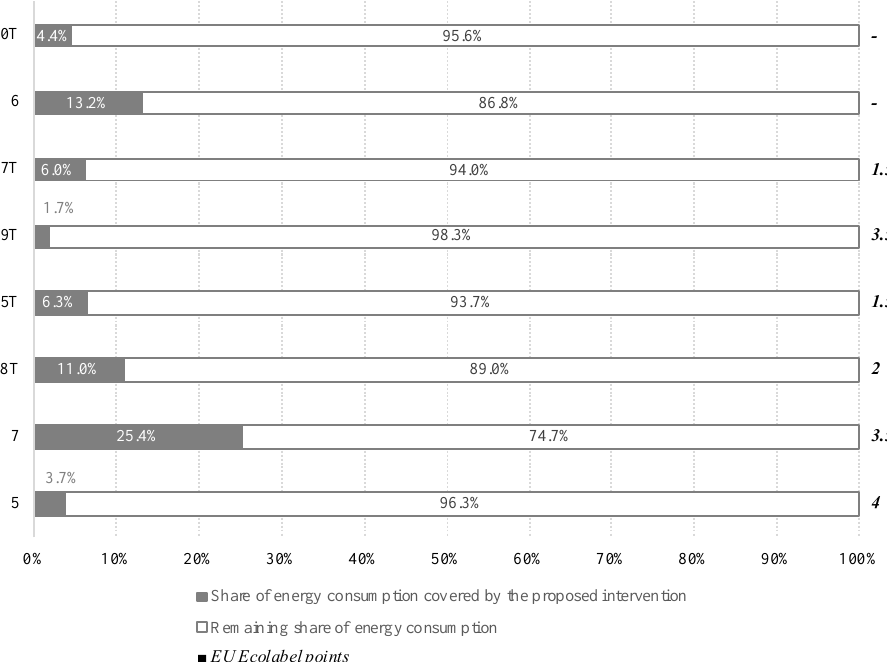
Figure 3. Achievable energy savings (AES), on an annual basis, and EU Ecolabel points relative to each considered ARERA datasheet for Bergi agritourism.